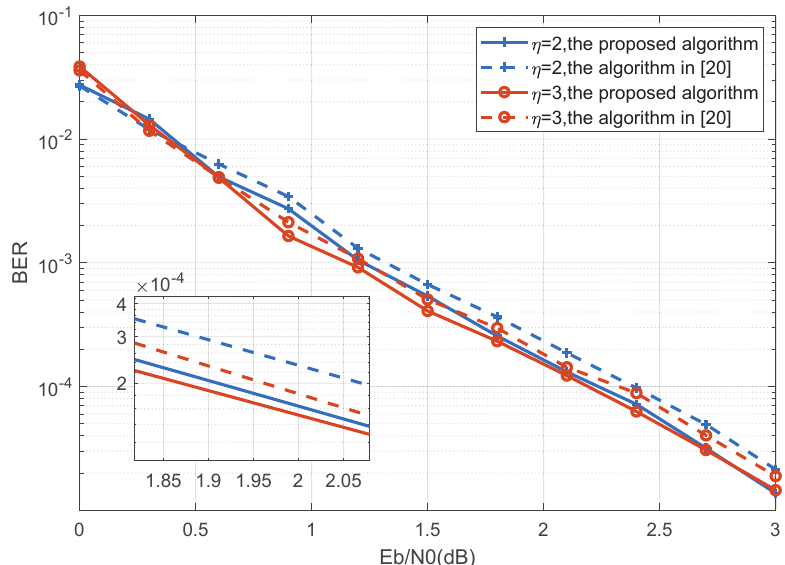
Figure 8. BER performance of turbo-Hadamard codes with different memory depths.